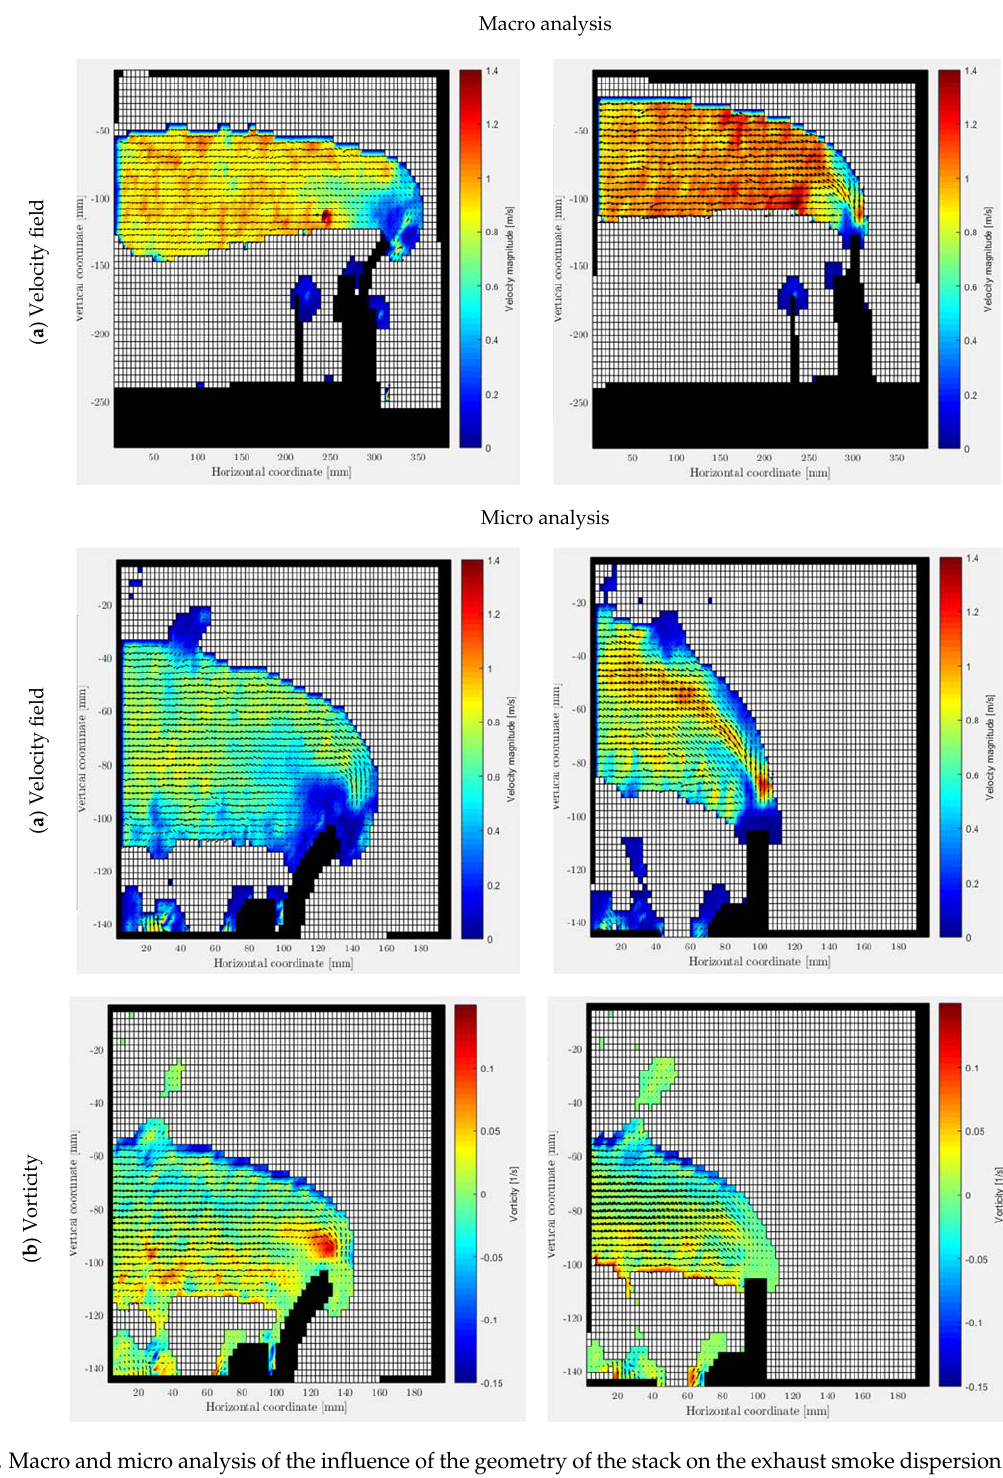
Figure 8. Macro and micro analysis of the influence of the geometry of the stack on the exhaust smoke dispersion. The macro analysis is performed in terms of the velocity fields for an inflow condition of 1 m ∙ s − 1 and a North ‐ Easterly wind direction, while the micro analysis was performed for both velocity field (for an inflow condition of 1 m ∙ s − 1 and a North ‐ Easterly wind direction) ( a ) and vorticity (for an inflow condition of 2 m ∙ s − 1 and a North ‐ Easterly wind direction) ( b ). The vorticity field shows a sequence of equidistant vortices at the plume/ambient flow interface rotating along a trigonometric direction (red stands for positive—counter ‐ clockwise rotation and higher vorticity, while blue stands for negative—clockwise rota ‐ tion and higher vorticity). It also appears that in the lower section of the plume, similar vorticity patterns have formed, but their rotation very logically takes place in the opposite direction, as this constitutes a resting flow zone. In the wake zone, the results highlight the disorderly formation of vorticity patterns. These findings are in accordance with the work of [23], for a velocity ratio Vs/V less than 1.